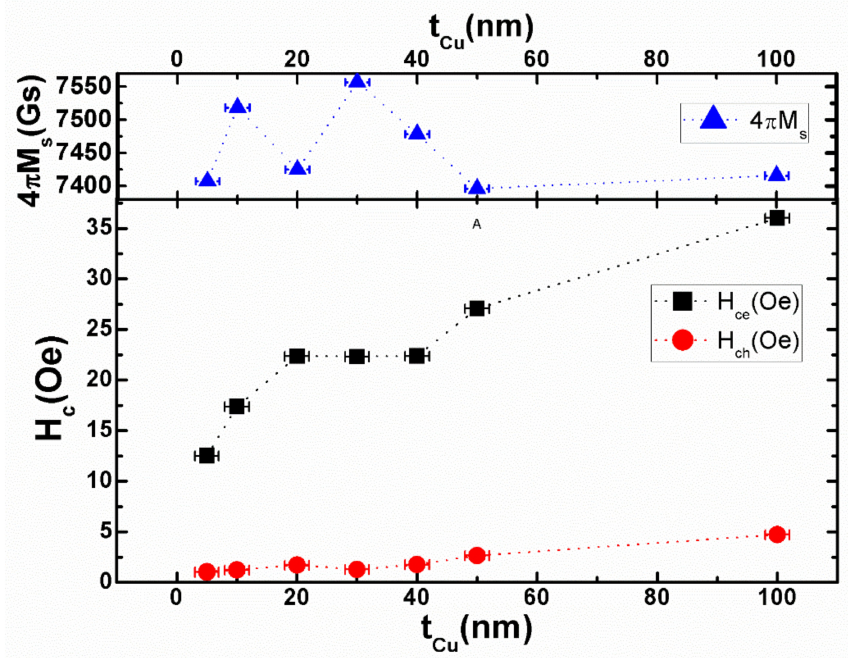
Figure 3. The t Cu dependence of the saturation magnetization (4 π M s ), the easy axis ( H ce ) and hard easy ( H ch ) coercivity for Cu/Ni 80 Fe 20 thin films.